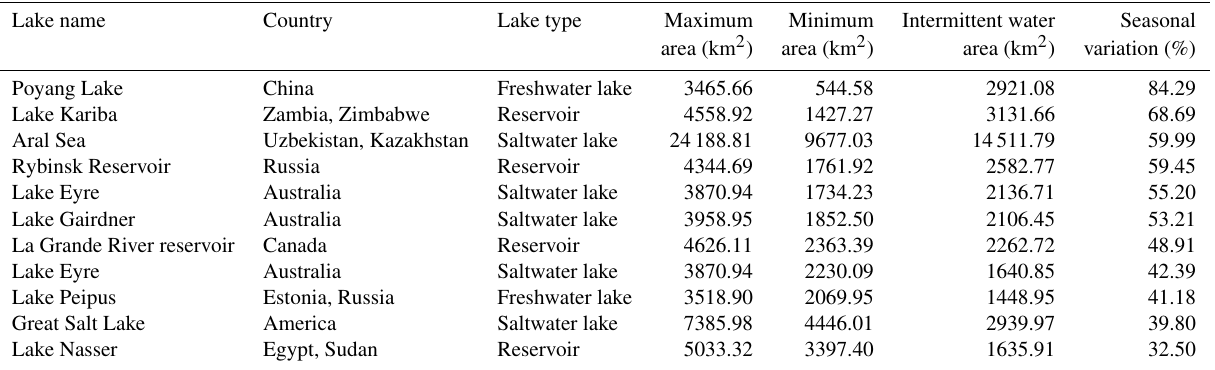
Figure 9. The seasonal variation and interannual change of surface water cover of Poyang Lake (28.28–29.89 ◦ N, 115.62–117.05 ◦ E). (a) The GLOBMAP SWF map in 2020. (b) The interannual variation of the area of Poyang Lake with different inundation frequency and average value of the count of available clear-sky observations ( N clear ) over the maximum surface water extent from 2001 to 2020. Table 1. Global top 10 lakes with the largest seasonal variation in